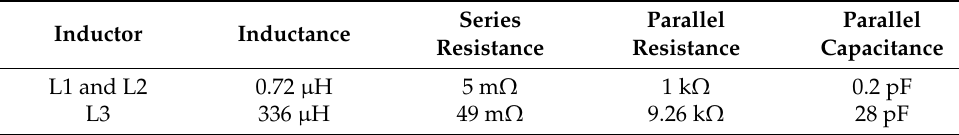
Figure 6. Schematic of the zero voltage switching (ZVS) induction welding circuit used for power transfer to IOFEF joints. Table 1. Parameters of the work coil and inductor for the LTspice model.